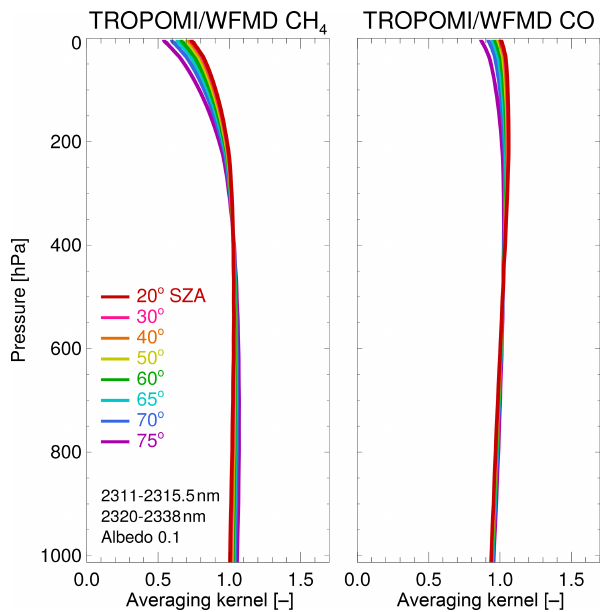
Figure 2. CH 4 and CO column averaging kernels reflecting the al- titude sensitivity of the retrievals.